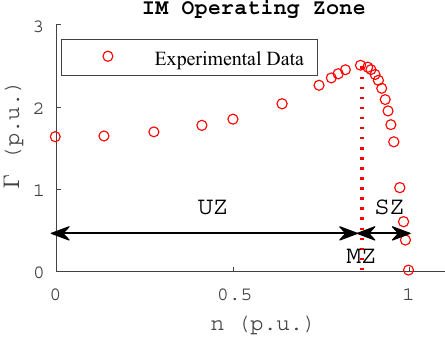
Figure 4. Operating zones of the IM in the torque–speed curve.